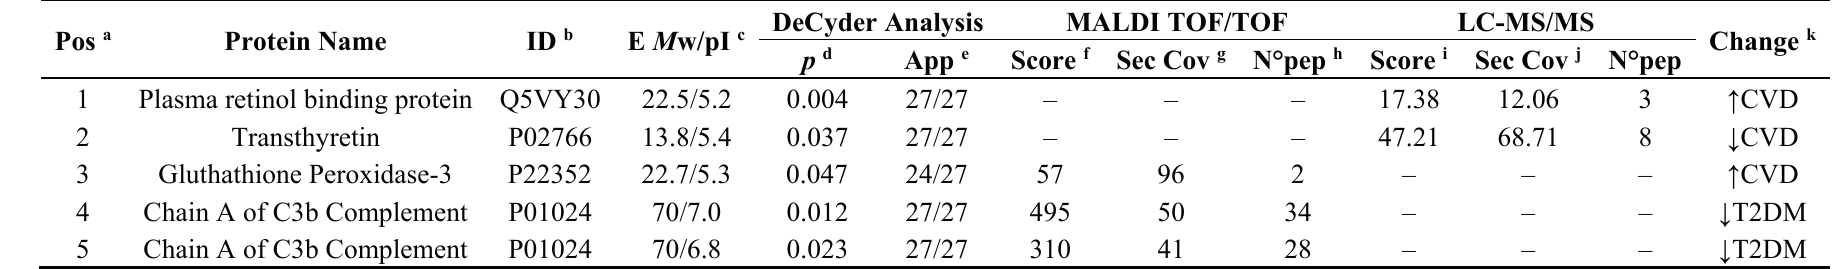
Table 2. List of the candidate biomarkers identified by MALDI-TOF/TOF or LC-MS/MS